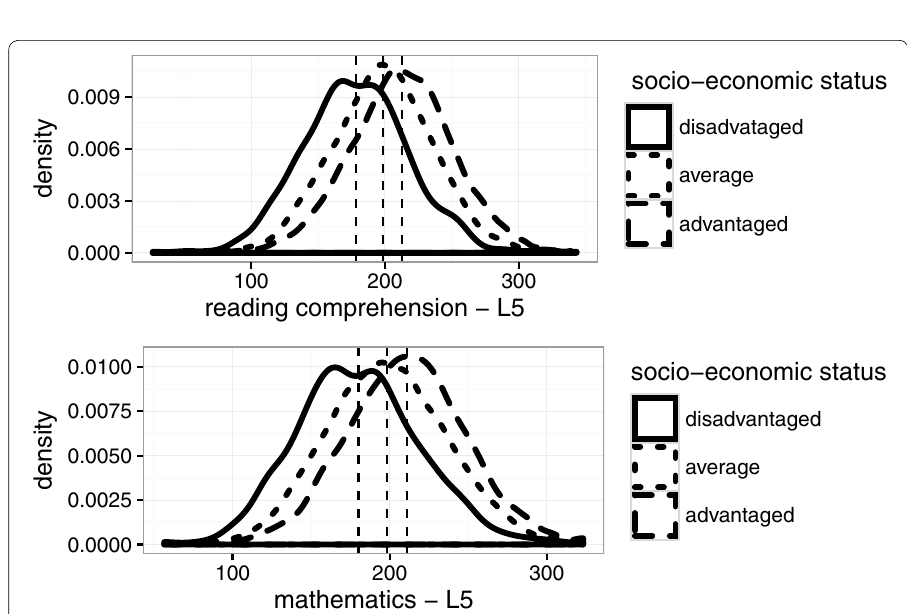
Fig. 2 Reading comprehension and mathematics achievement for fifth-graders according to the level of socio-economic status. The ESCS index has been divided into three levels: disadvantaged students, those with ESCS value in the range ( 2.79, 1.1], students with average socio-economic status in the class ( − − 0.583] and advantaged students with ESCS value in the range (0.583, 2.27]. The vertical dotted lines